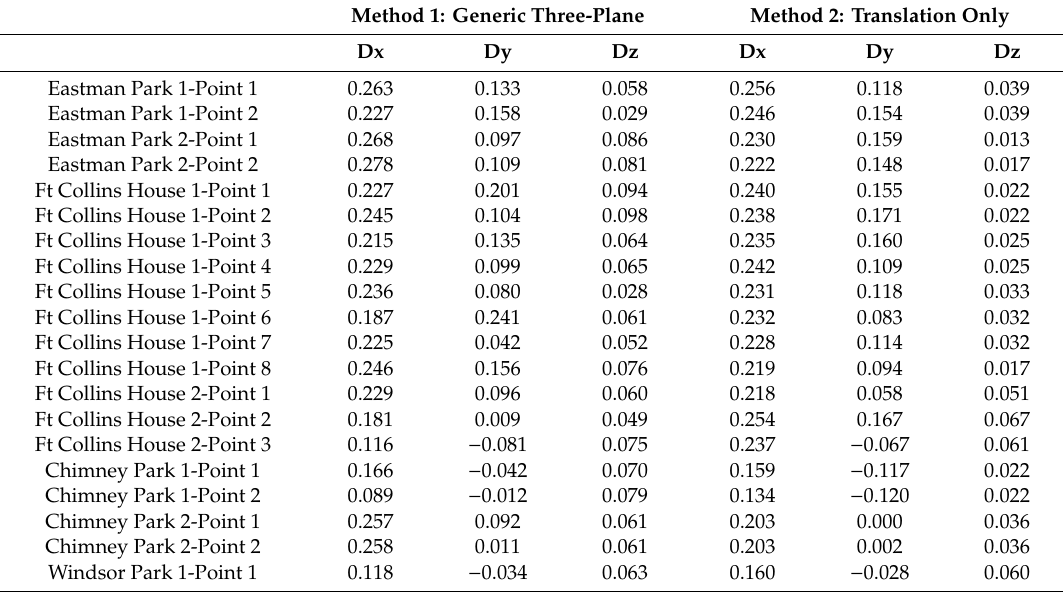
Table 4. 3D absolute analysis results in meters.